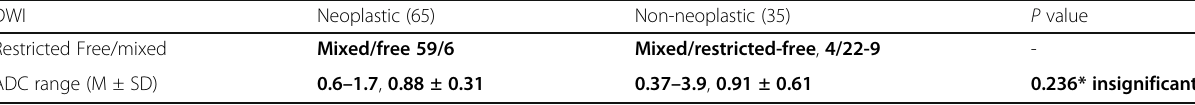
Table 5 DWI and ADC values for all neoplastic and non-neoplastic lesions DWI